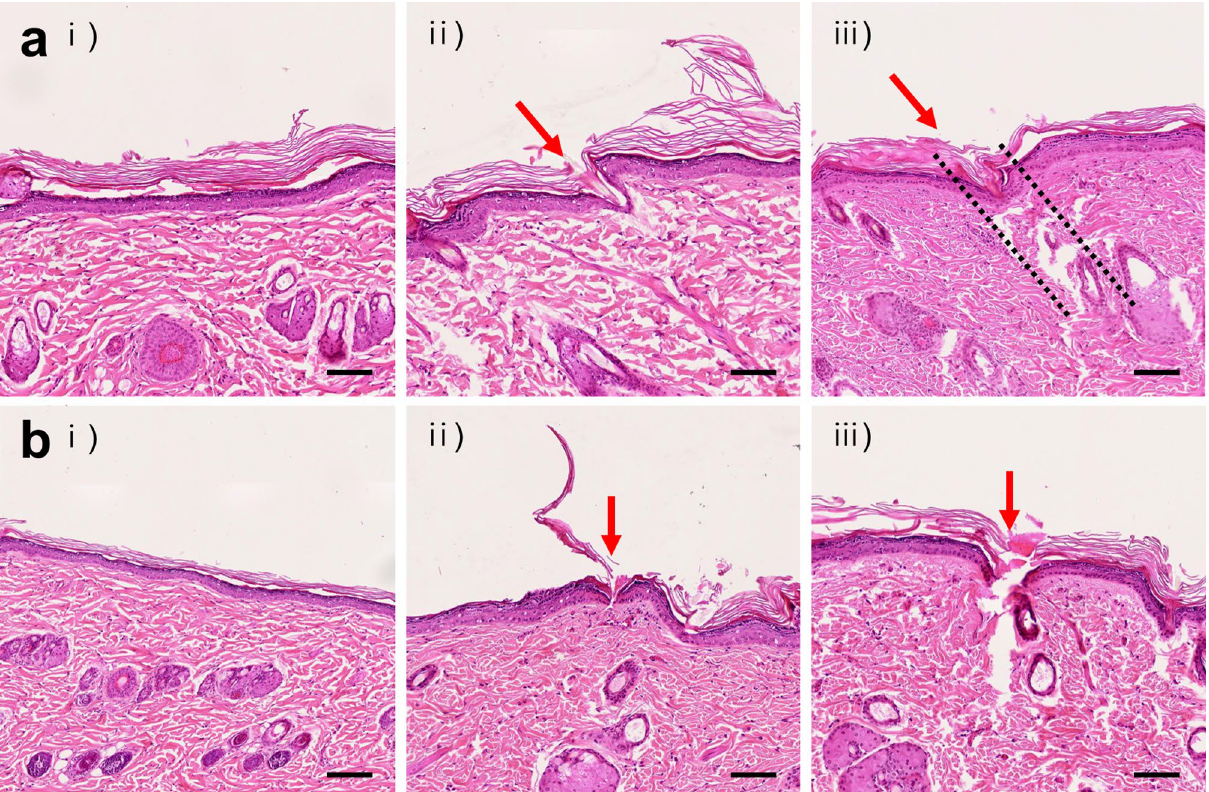
Figure 6. Histological images of rat skin. Representative histological images of rat skin tissues after application of TMICS ( a ) and SMICS ( b ). (i) Untreated skin (Control), (ii) skin poked five times, and (iii) skin poked ten times with the devices. Red arrows [in (ii), (iii)] and black dashed lines [in a (iii)] indicate the trace of MN penetration. All scale bars are 100 μm. (n = 3